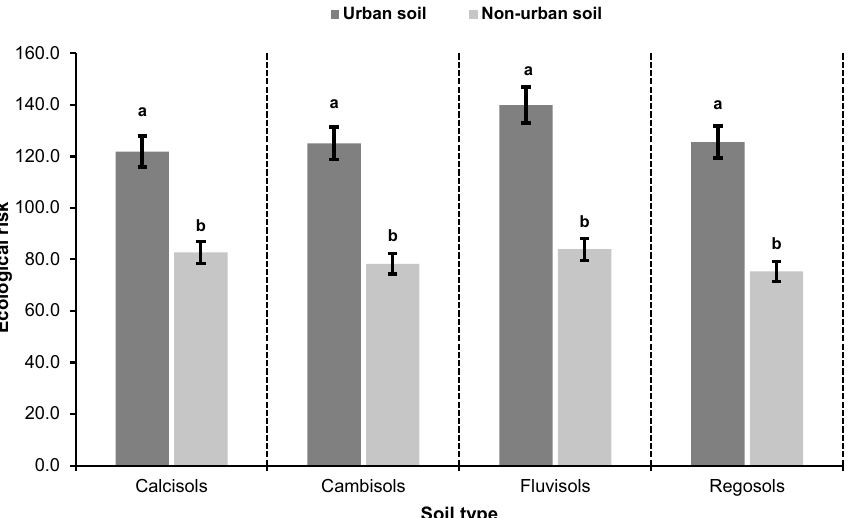
Figure 4. The comparison of the mean ecological risk of selected heavy metals between urban and non-urban soils in different soil types. Different letters indicate significant differences in ecological risk within each soil type at P < 0.05 confidence interval.